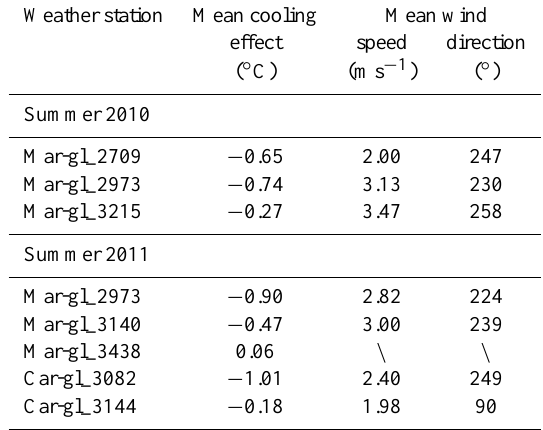
Table 4. Mean values of cooling effect, wind speed, and wind di- rection recorded at the on-glacier weather